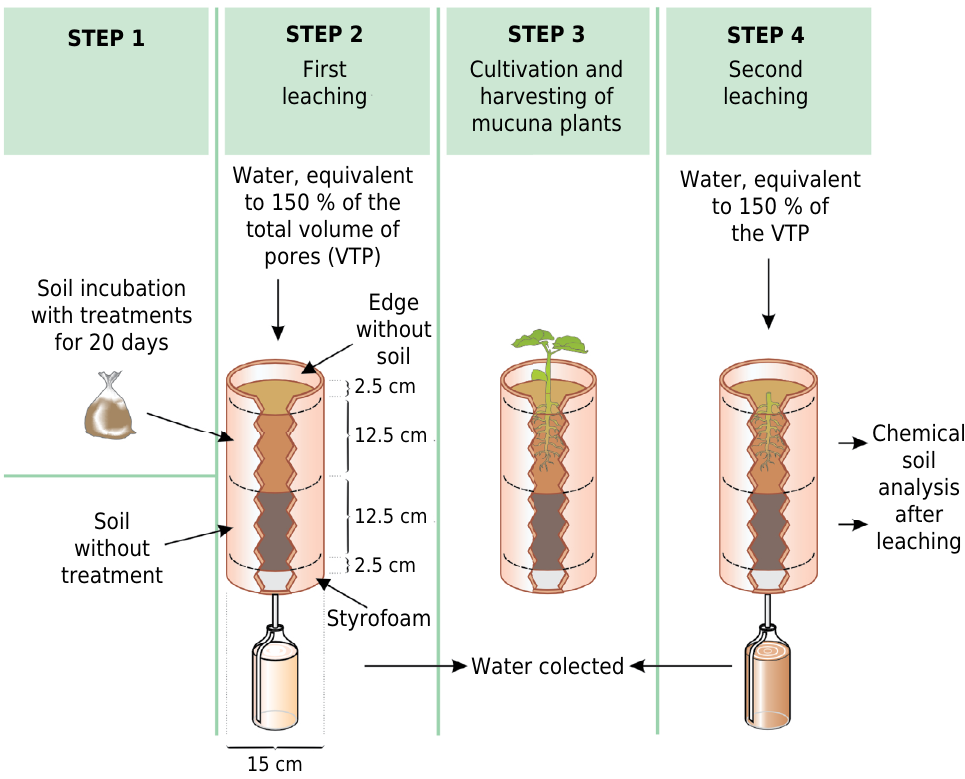
Figure 1. Scheme of the experiment steps for measuring leaching of K in soil columns treated with or without biochar in association with three levels of potassium and then cultivated with mucuna (for 40 days). The plastic bag soil (step 1) was treated with or without biochar and three levels of K. In step 2, the surface part of the pots was filled with soil from the bags (treated soil and incubated) and lower layer being filled with the same soil, but without treatment and without incubation. Chemical analysis was performed on the water collected in steps 1 and 4.